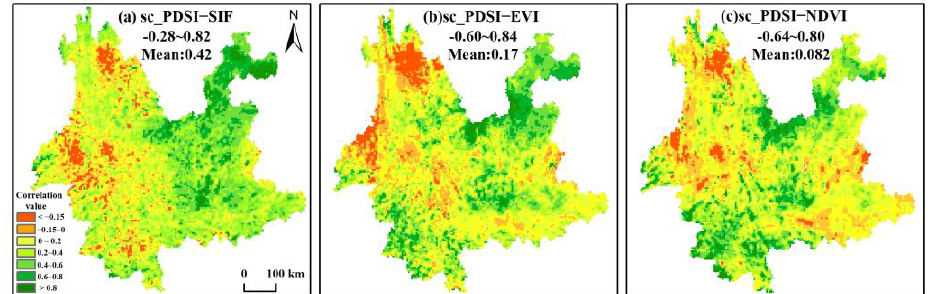
Figure 2. Distribution of monthly average values in Yunnan Province from 2009 to 2011: ( a ) SIF; ( b ) EVI; ( c ) NDVI; ( d ) sc_PDSI.